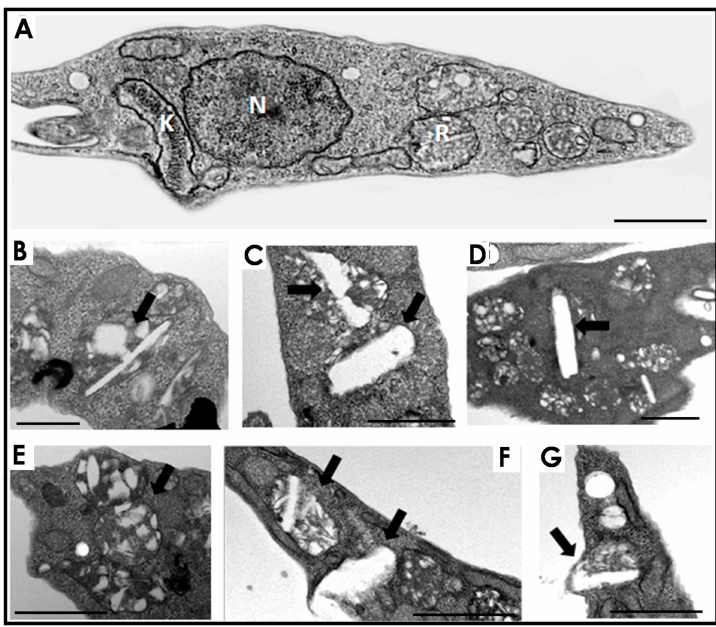
Figure 1. Effects of lopinavir and nelfinavir on the reservosomes of T. cruzi epimastigotes. ( A ) Transmission electron microscopy of control parasites revealed the normal morphology of organelles such as nucleus (N), kinetoplast (K) and reservosome (R). The treatment with lopinavir ( B – D ) and nelfinavir ( E – G ) induced a huge appearance of lipid inclusions inside the reservosomes ( black thick arrows ). Bars = 500 nm. The images are a representative set of three independent